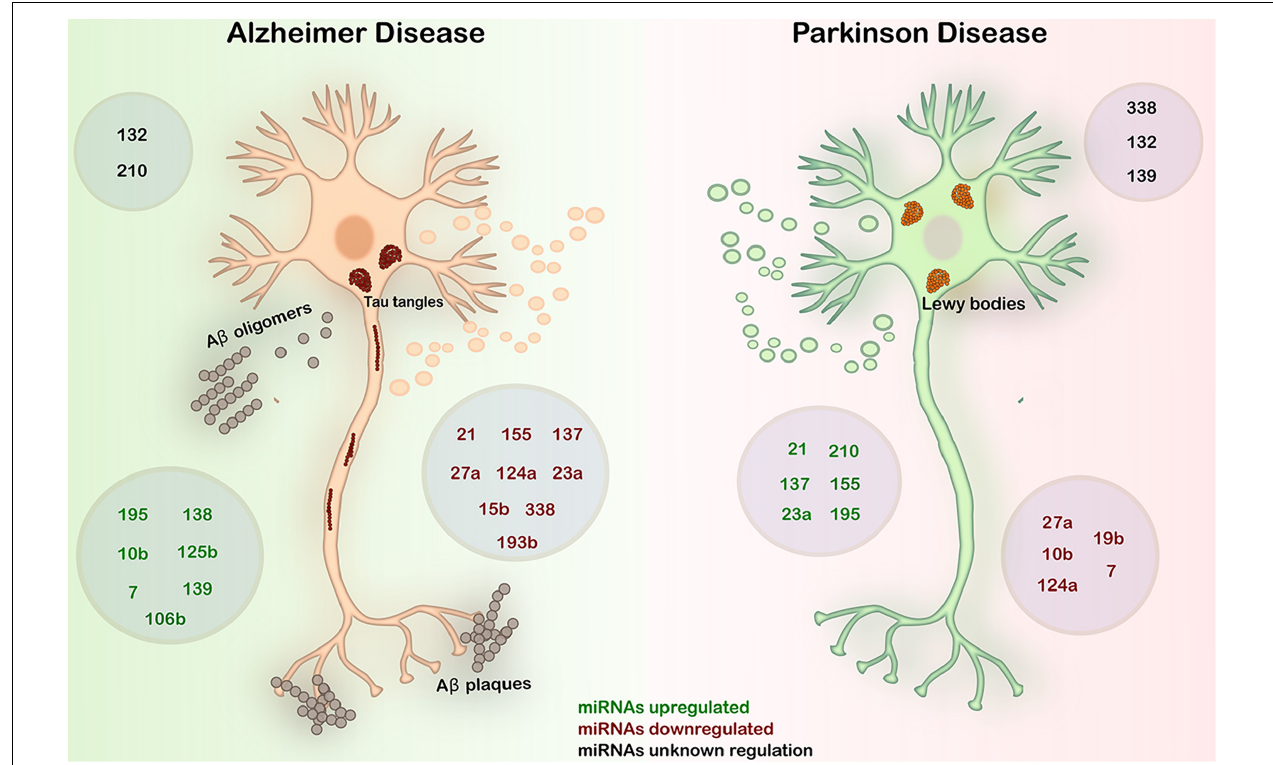
FIGURE 3 | Expression in AD and PD of the most deregulated miRNAs in GBM. AD is characterized by the deposition of A β fibrils in the brain parenchyma and vessel walls and by the accumulation of aberrant phosphorylated Tau protein in neurons. PD is an α -synucleinopathy characterized by the formation of Lewy bodies by the accumulation of α -synuclein predominantly in neurons, causing the loss of dopaminergic neurons. In both diseases, abnormal regulation of miRNAs plays a key role in the onset and progression of the diseases. Black – miRNAs with unknown regulation in AD and PD; green – miRNAs upregulated in AD and PD; red – miRNAs downregulated in AD and